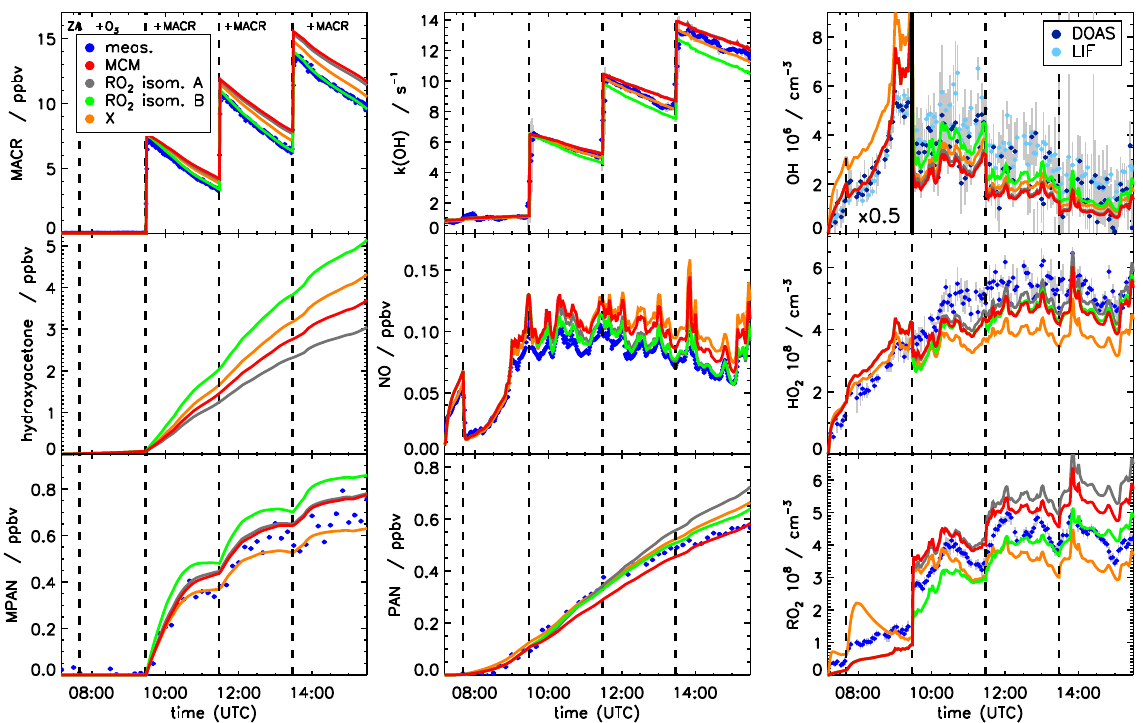
Figure 4. Measured and modelled time series of MACR, k (OH), PAN, MPAN, RO 2 , HO 2 , OH, and NO for the experiment on 11 August 2011. OH prior to the addition of MACR is scaled by a factor of 0.5. Different model runs were performed applying the MCM, the MCM with two additional RO 2 isomerization reaction schemes (case A and B; see Table 4), and MCM with additional generic OH recycling (“X”) with an NO equivalent of 50pptv. Only calculated hydroxyacetone concentrations are shown, because hydroxyacetone was not measured during experiments.